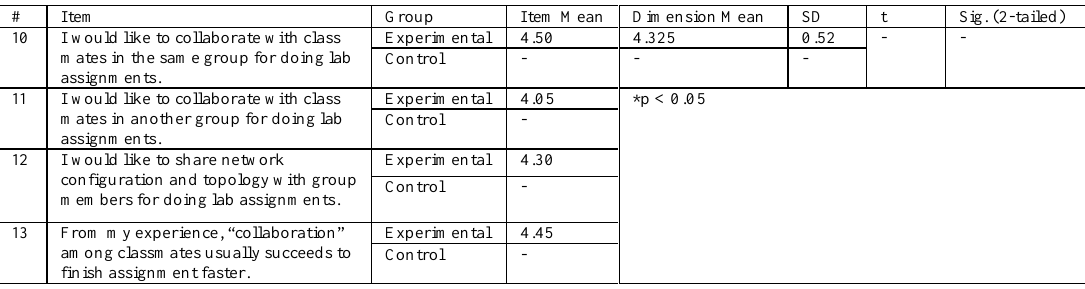
Table 4 Perceived Usefulness of NVBLab for Collaborative Group work.